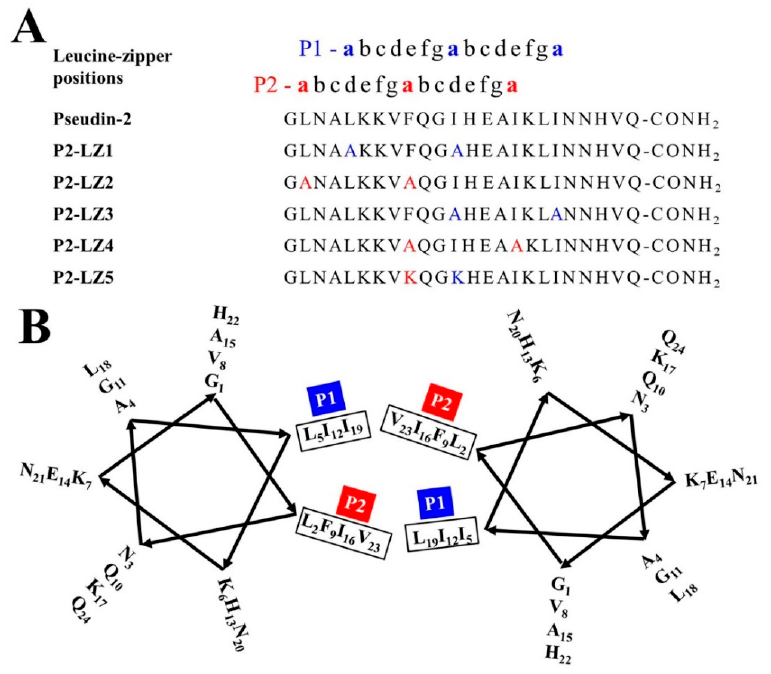
Figure 1. Amino acid substitutions in the leucine-zipper motif of pseudin-2. ( A ) Amino acid sequences of the designated peptides. Amino acids at position “a” are indicated in red and blue colors. ( B ) Helical wheel projection of psuedin-2 in the leucine-zipper orientation.